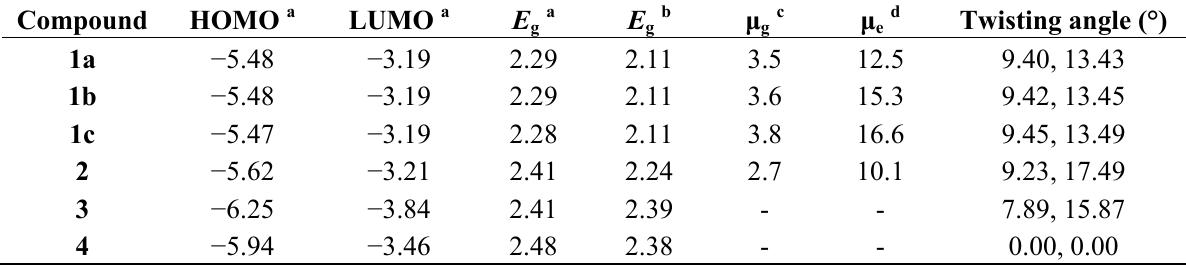
Table 2. Calculated and experimental parameters for perylene bisimide